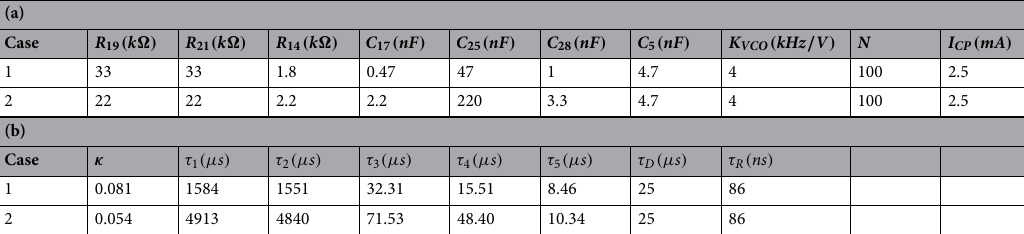
Table 1. Loop filter component and system parameter values; (a) Component values for two different instances of loop filter design; (b) model parameters derived from component values (see supplementary material for formulae).